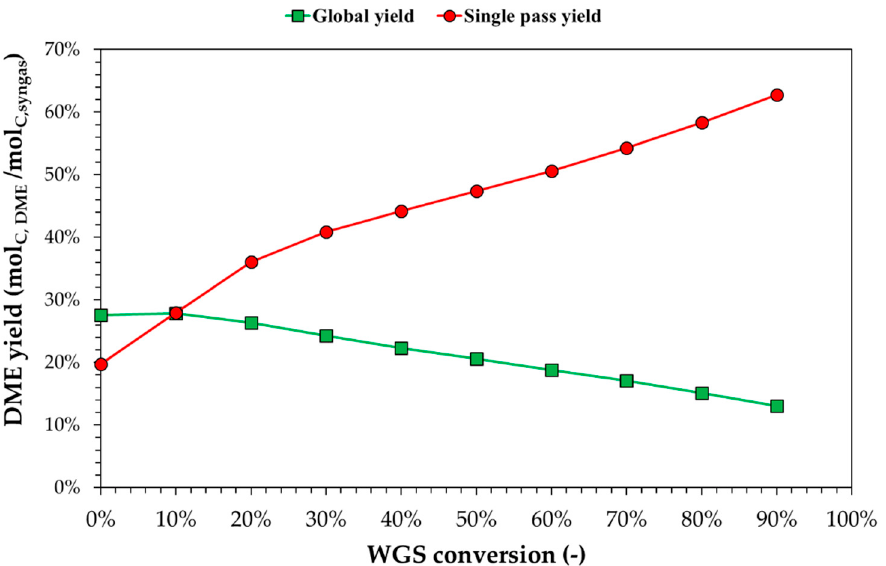
Figure 10. Theoretical equilibrium DME yield (global or single pass) with respect to the WGS conversion, fixing CO 2 capture and the purge ratio to 85% and 10%, respectively.